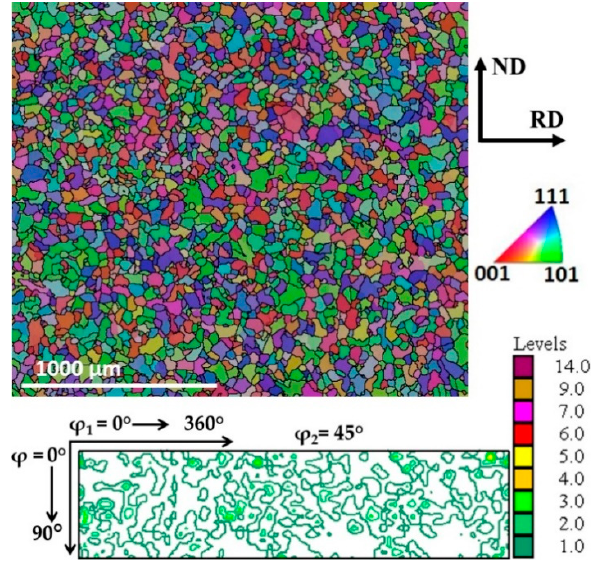
Figure 2. The initial microstructure (EBSD IPF map) and texture (the φ 2 = 45° ODF section) of extra low carbon steel after heat treatment. EBSD, Electron back scattered diffraction; IPF, Inverse Pole Figure; ODF, orientation distribution function.